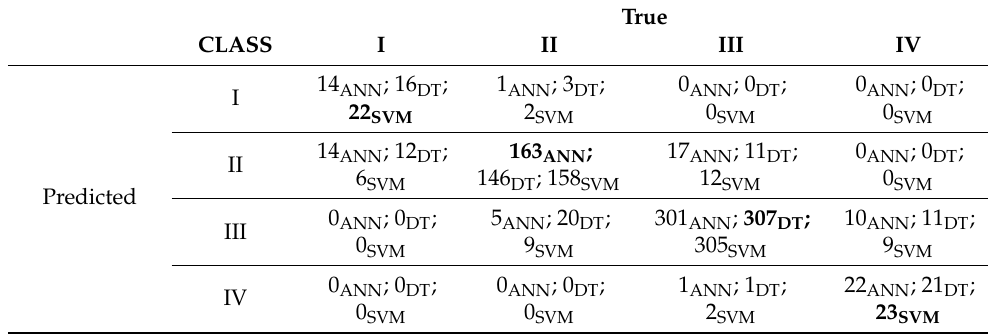
Table 9. Confusion matrix for ANN, DT, and SVM.